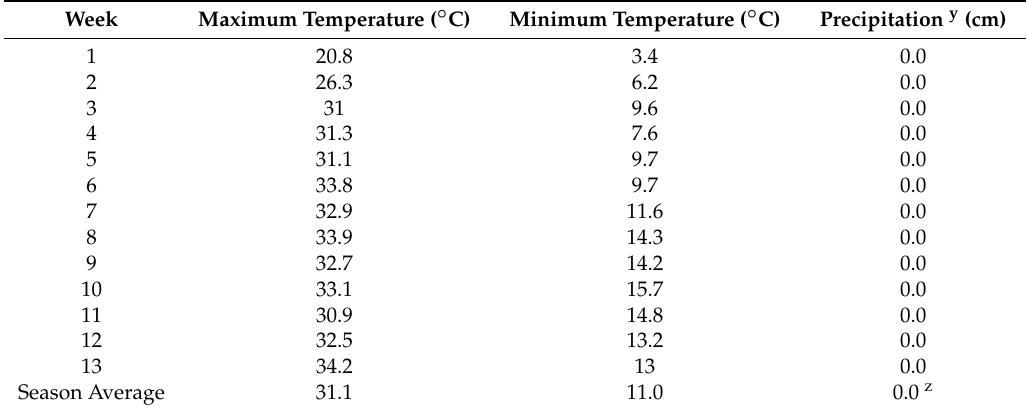
Table 1. Growing season (17 May–12 August 2011) weekly total precipitation and average maximum and minimum temperatures x , 2011.